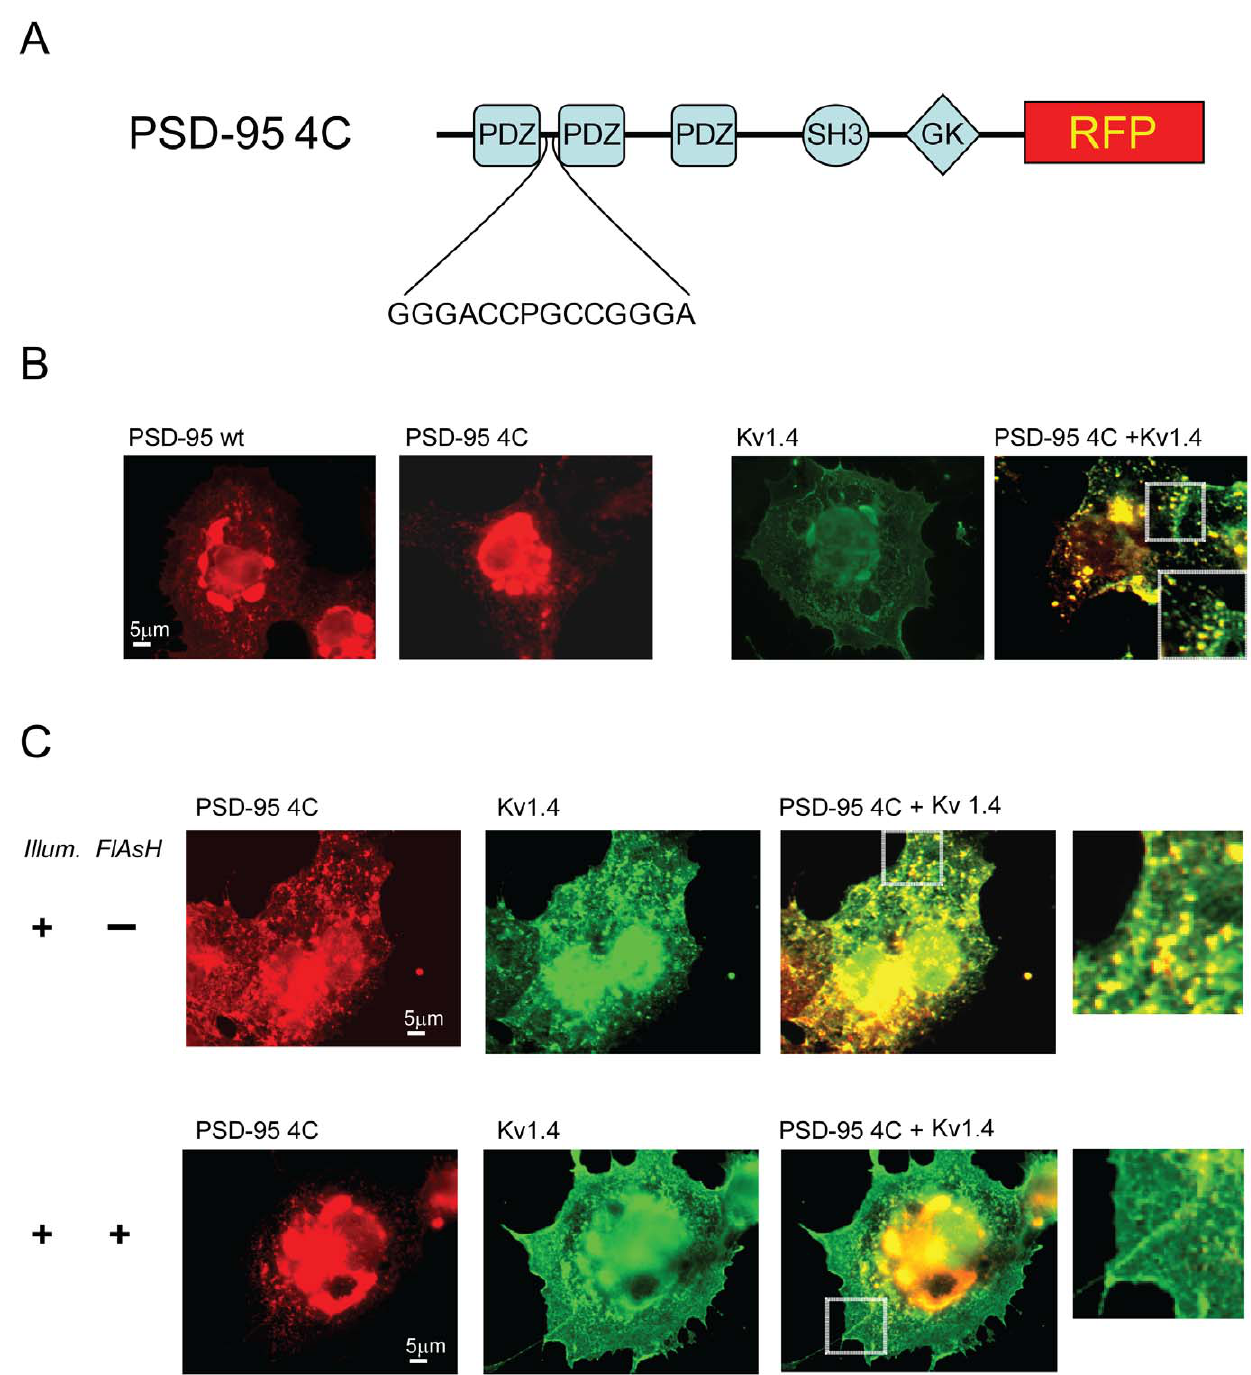
Figure 1. Fluorescein-assisted light inactivation (FALI) of PSD-95-4c redistributes Kv1.4 in COS7 cells. (A) A tetracysteine motif was engineered between PDZ1 and PDZ2 of PSD-95 for binding of FlAsH. (B) COS7 cells were transfected with PSD-95 or PSD-95-4c or co-transfected with PSD-95-4c and Kv1.4. Immunofluorescence experiments show perinuclear distribution of labeled proteins in single transfected cells. Double transfected cells show clustering of labeled proteins (see insert). (C) COS7 cells were co-transfected with PSD-95-4c and Kv1.4 for three days. Cells were then incubated in the presence or absence of 1 m M FlAsH-EDT 2 at 37 u C, washed and illuminated for 2 minutes. After illumination, cells were incubated at 37 u for 15 minutes before fixation and immunostaining. doi:10.1371/journal.pone.0053965.g001 mEPSCs (about 100 events per cell) were automatically detected GTP, 5 mM QX-314, and 0.1 mM spermine (pH 7.2). using in-house software. Picrotoxin and TTX were from Sigma.